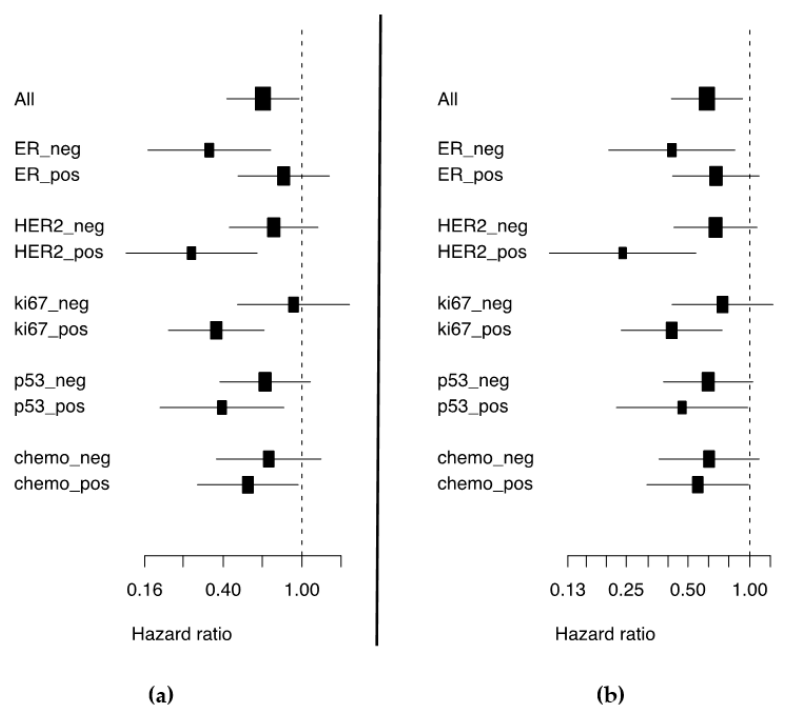
Figure 1. Forest plots depicting the hazard ratio and corresponding confidence intervals for ( a ) 5-